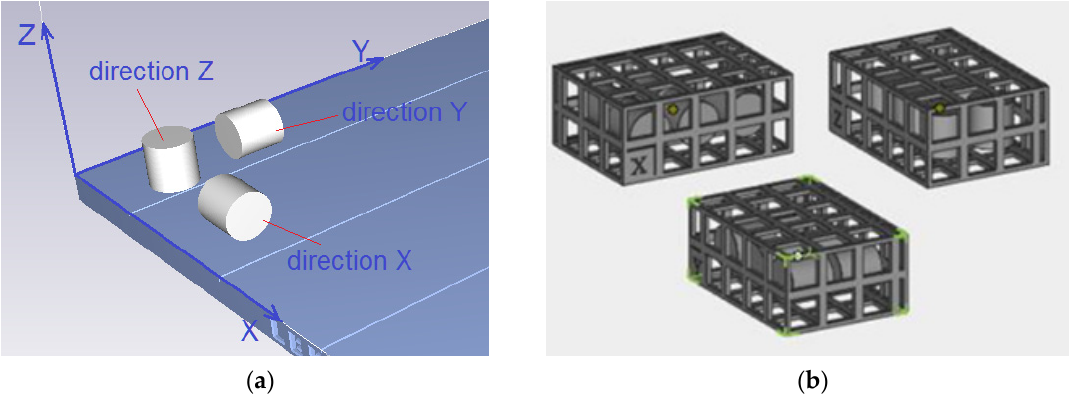
Figure 1. Specimens built in three directions, ( a ) orientation on the build tray, ( b ) arrangement in the protective baskets.